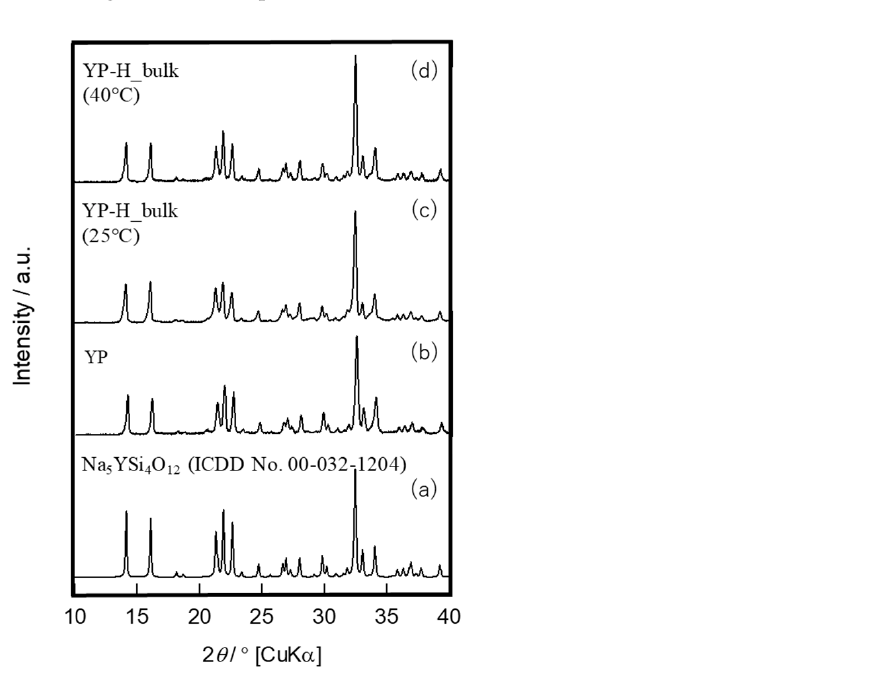
Figure 8. XRD patterns of ICDD data ( a ); original ( b ); ion exchanged bulk exchange at 25 °C ( c ); and 40 °C ( d ).